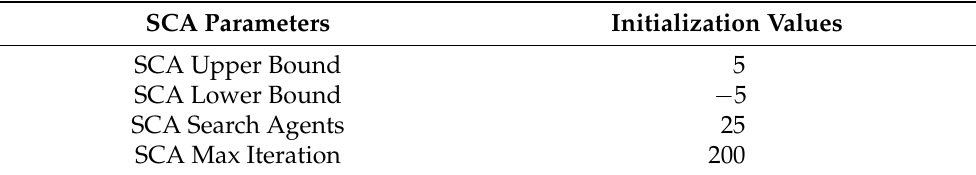
Table 3. Sine Cosine Algorithm (SCA) setup.